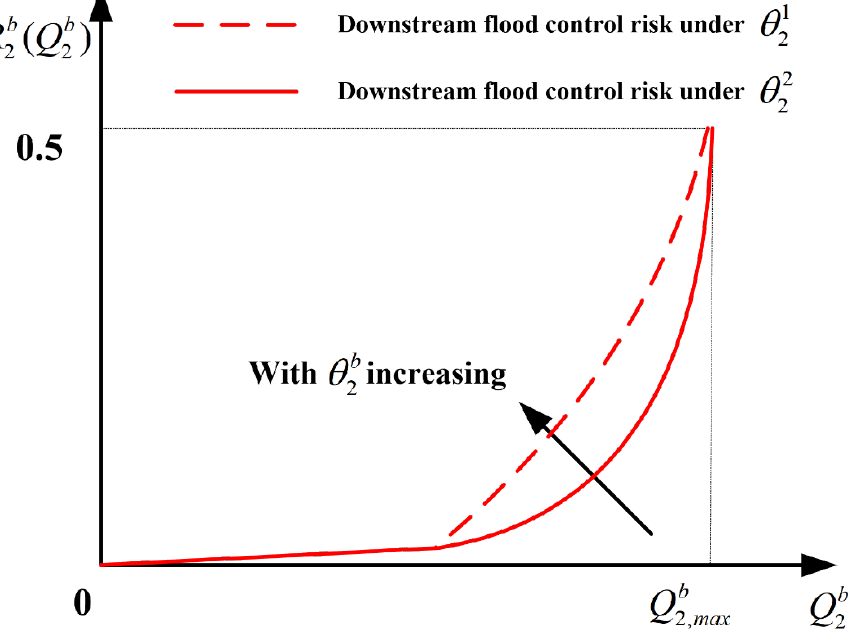
Figure 6. Diagram of the relationship between combined inflow and downstream flood control risk rate in stage 2.